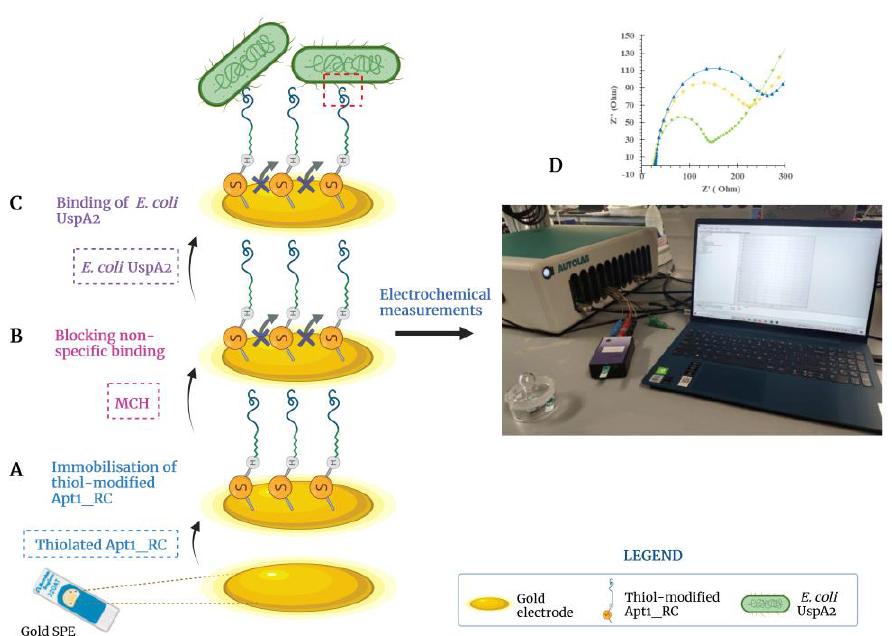
Figure 5. Illustration of the developed electrochemical biosensor to detect Escherichia coli UspA2. ( A ) Apt1_RC was immobilized on the gold electrode surface; ( B ) non-specific binding was blocked with 6-mercapto-1-hexanol (MCH); and ( C ) selective binding between E. coli UspA2 and Apt1_RC. ( D ) The electrochemical response is measured after each assembly step and during the analytical analysis of the performance of the aptasensor. Created with BioRender.com.